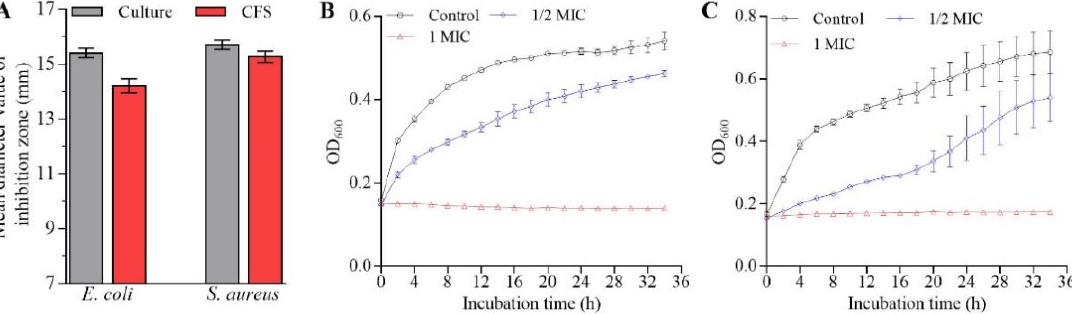
Figure 1. Antimicrobial activity of L. rhamnosus SCB0119 against E. coli ATCC25922 and S. aureus ATCC6538. ( A ) The mean diameters of inhibition zones after E. coli ATCC25922 and S. aureus ATCC6538 were incubated with L. rhamnosus SCB0119 culture solution and CFS for 12 h, respectively. ( B , C ) Effects of CFS on the growth of E. coli ATCC25922 and S. aureus ATCC6538, respectively. Error bars: SD of the mean from three repeated assays.